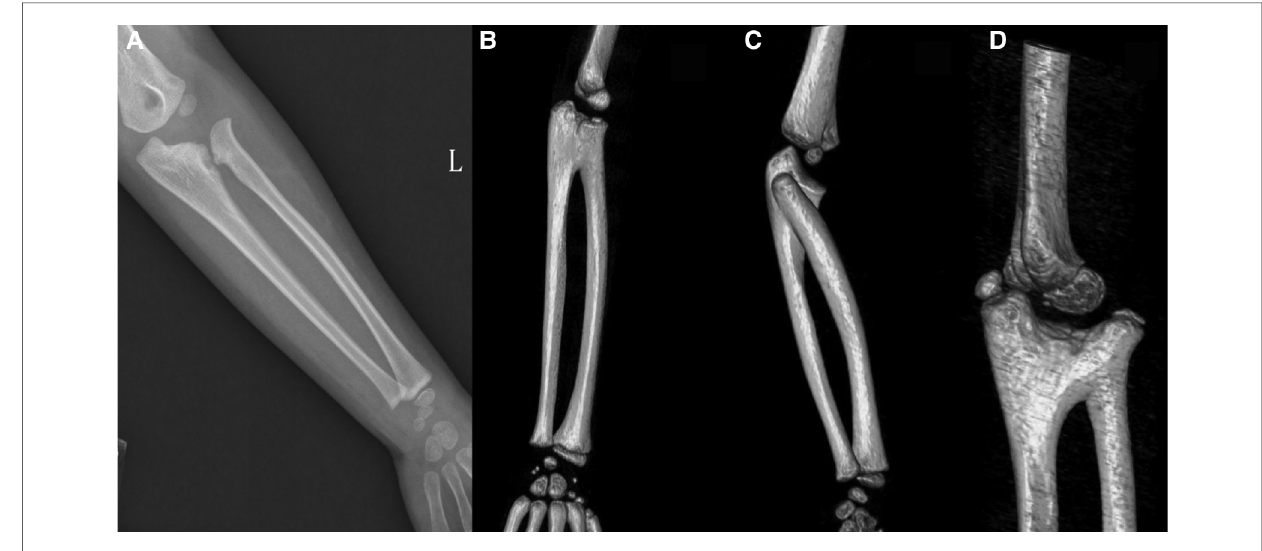
FIGURE 1 X-ray or CT reconstruction of forearm deformities. ( A ) C & O Type I; CMPOS Type I. ( B ) C & O Type II; CMPOS Type II. ( C ) C & O Type III; CMPOS Type III. ( D ) C & O Type IV; CMPOS Type